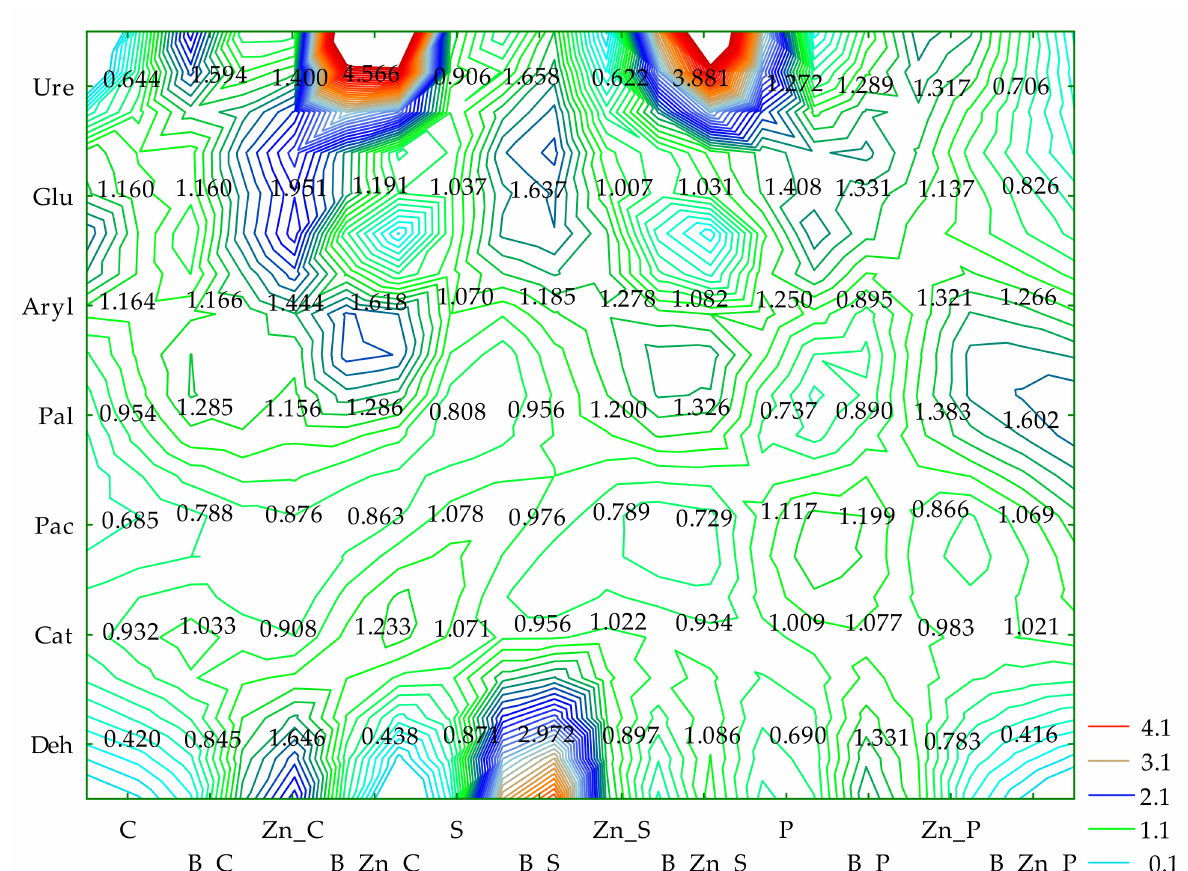
Figure 2. The coefficient of the influence of humic acid (IF H ) on the activity of dehydrogenases (Deh), catalase (Cat), urease (Ure), acid phosphatase (Pac), alkaline phosphatase (Pal), arylsulfatase (Aryl), and β -glucosidase (Glu) in soil uncontaminated and contaminated with B, Zn 2+ , and B + Zn 2+ ; S— Sorghum Moench ; P— Panicum virgatum ; C—uncontaminated soil; B—bisphenol A; Zn—ion zinc (Zn 2+